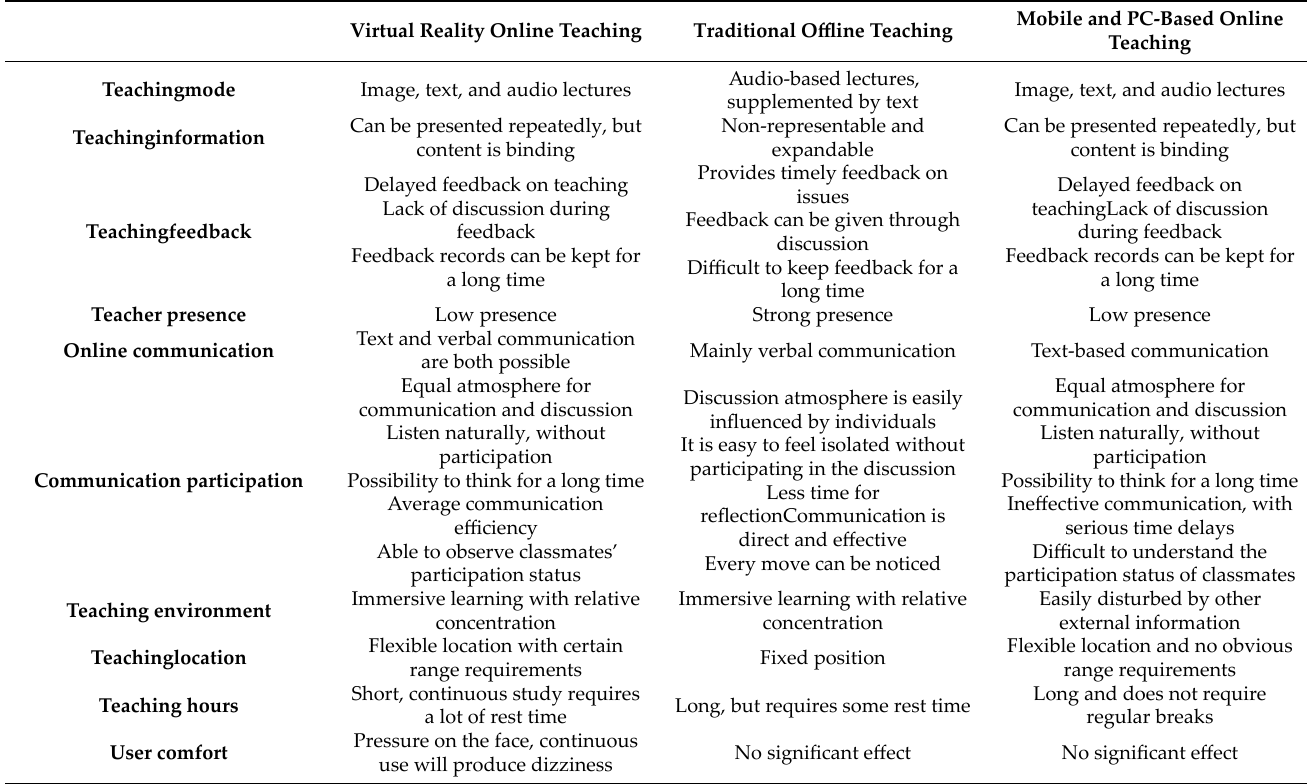
Table 1. Summary of the comparison of the characteristics of different educational